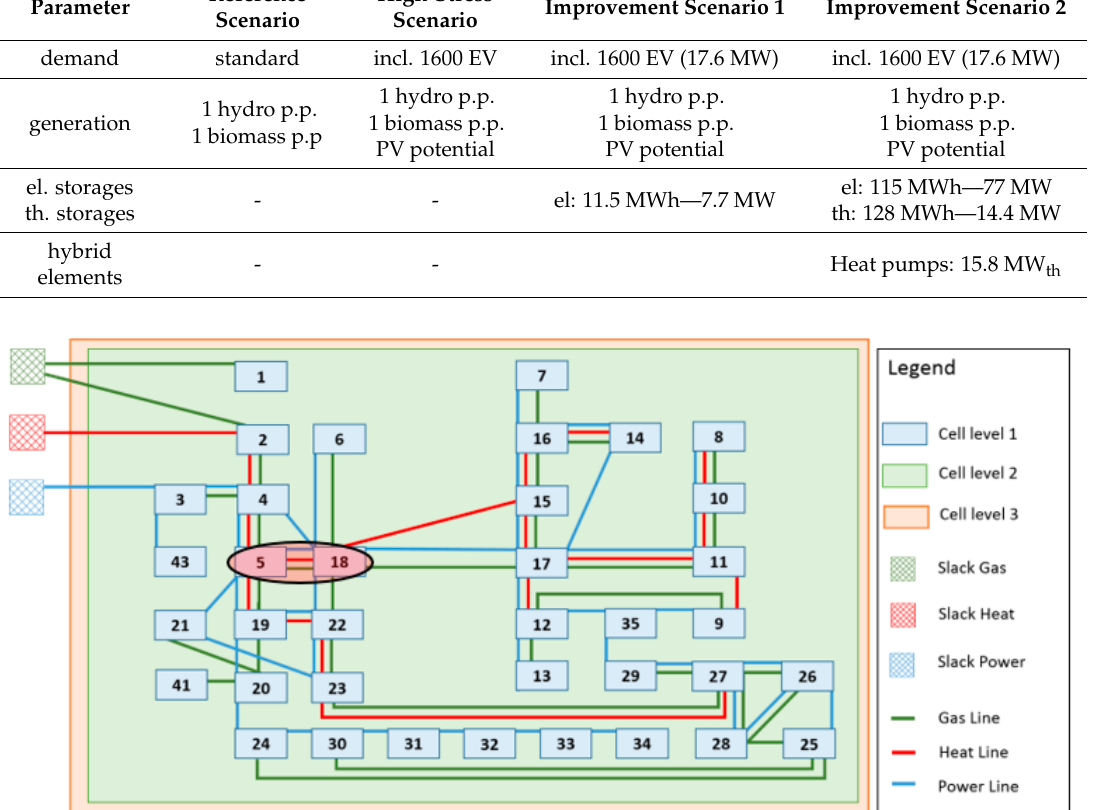
Figure 7. Results of all deployed scenarios of case study 1. 5.2. Case Study 2: Region